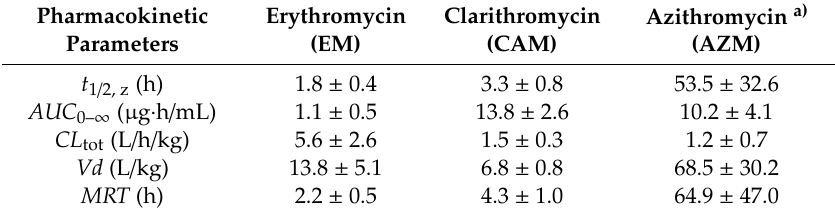
Table 1. Pharmacokinetic parameters after intravenous administration of erythromycin (5 mg/kg) or clarithromycin (20 mg/kg) to rats, and comparison with previously reported results on azithromycin (10 mg/kg).